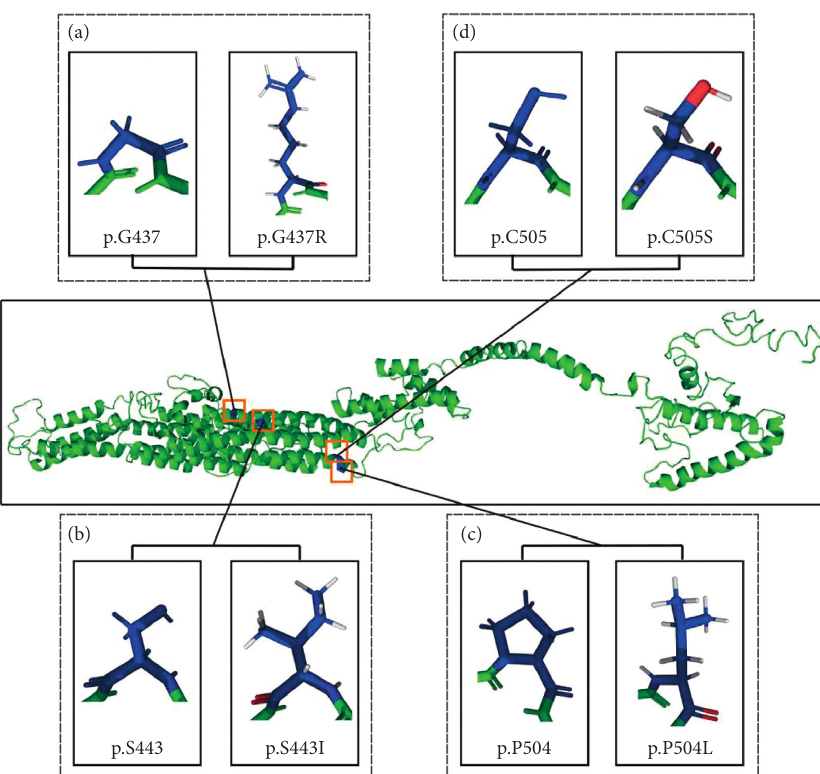
Figure 5: The 3D conformation of four mutation sites located in the transmembrane domain of WFS1 , as predicted by modeling software. (a) The 3D conformation of the wild type WFS1 437th amino acid glycine and mutant arginine. (b) The 3D conformation of the wild type WFS1 443rd amino acid serine and the mutant isoleucine. (c) The 3D conformation of the wild type WFS1 504th amino acid proline and the mutant leucine. (d) The 3D conformation of the wild type WFS1 505th amino acid cysteine and mutant serine. 3D,